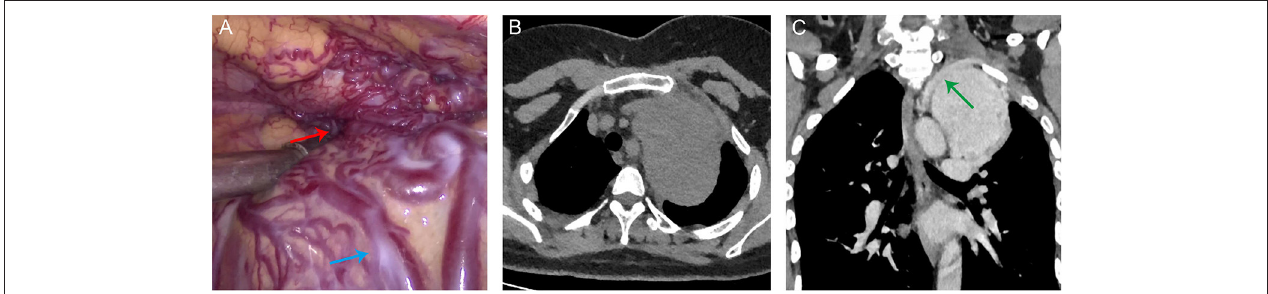
FIGURE 1 | (A) Intraoperative photograph showing abundant tortuous blood vessels on the surface of the tumor (blue arrow) and an unclear border at the top of the chest (red arrow). (B) A CT scan revealed a giant anterosuperior mediastinal tumor (6.7 × 9.8 × 9.7cm) near the left side of the aortic arch. (C) Contrast-enhanced CT scan showed that the tumor was surrounded by tortuous vessels and was poorly demarcated from the left subclavian artery (green arrow).